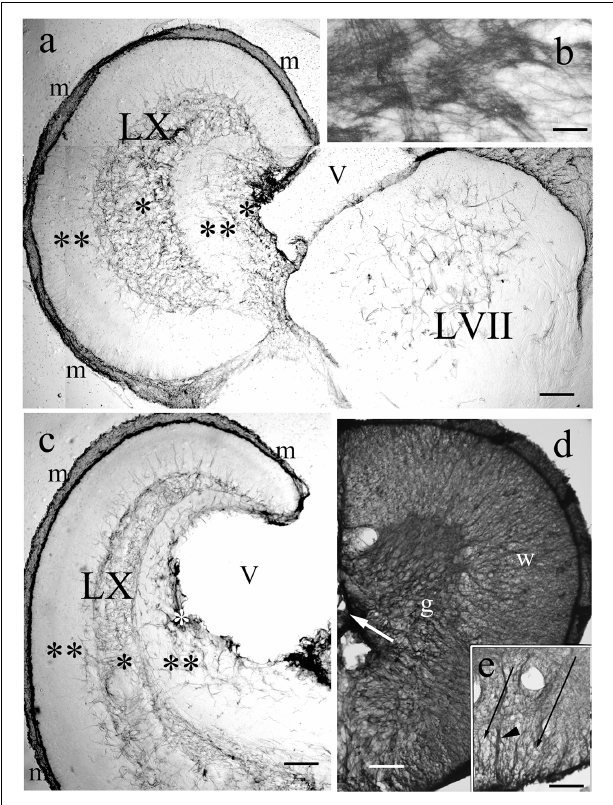
FIGURE 14 | Vagal and facial lobes, and spinal cord. (a) Through the facial lobe (LVII); LX: vagal lobe, m: meningeal surface, V: ventricle, asterisks: GFAP-rich layers, double asterisks: GFAP-poor layers. Crucian carp. Scale bar: 300 µ m. (b) The structure of the GFAP-immunopositive layer of panel ‘a’ enlarged Scale bar: 40 µ m. (c) Rostral to the level of panel ‘a,’ marks as before. Crucian carp. Scale bar: 300 µ m. (d) Bichir spinal cord, g: gray matter, dense plexus of glial processes; w: white matter, a less dense system of radial processes. Scale bar: 80 µ m. (e) The ventral part of the spinal cord of goldfish, arrowhead points to the midline septim, long thin arrows: light spots corresponding to myelinated axon bundles. Scale bar: 80 µ